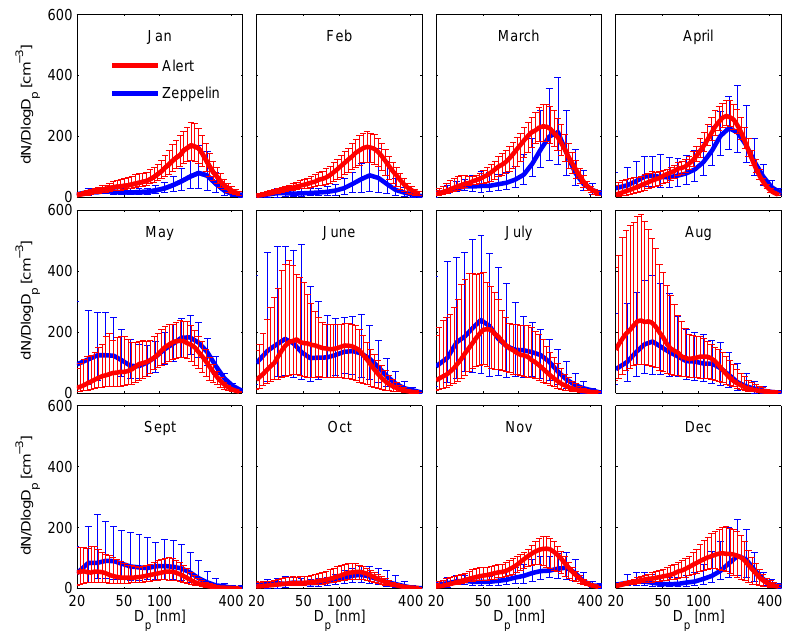
Figure 1. Measured monthly median number distributions from the scanning mobility particle sizer (SMPS) at Alert for 2011–2013 and the differential mobility particle sizer (DMPS) at Mt. Zeppelin for 2011–2013 for particle sizes between 20 and 500nm. Error bars show the 20–80th percentile of the